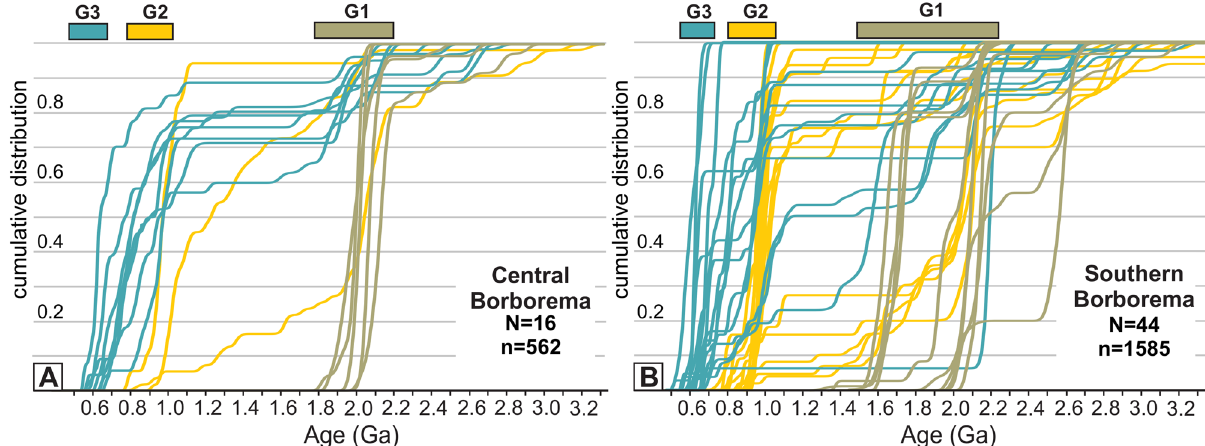
Figure 3. Provenance patterns of sedimentary rocks from central and south Borborema Province. ( A ) Cumulative probability plot showing the distribution of U–Pb ages from detrital zircon grains for samples from the central Borborema Province (region between the Pernambuco and Patos shear zones in Fig. 1). ( B ) Same as A, but for the southern Borborema Province (region between Pernambuco and the northern margin of the São Francisco Craton in Fig. 1). The distributions show three different patterns denoting different source areas: G1 cratonic provenance only, G2 Tonian extensional magmatic rocks plus cratonic provenance, and G3 Neoproterozoic orogenic magmatic rocks plus a variety of older sources. N is the number of rock samples; n is the total number of zircon grains analyzed. The bars on top of the diagrams depict the range of the youngest zircon grains found in each